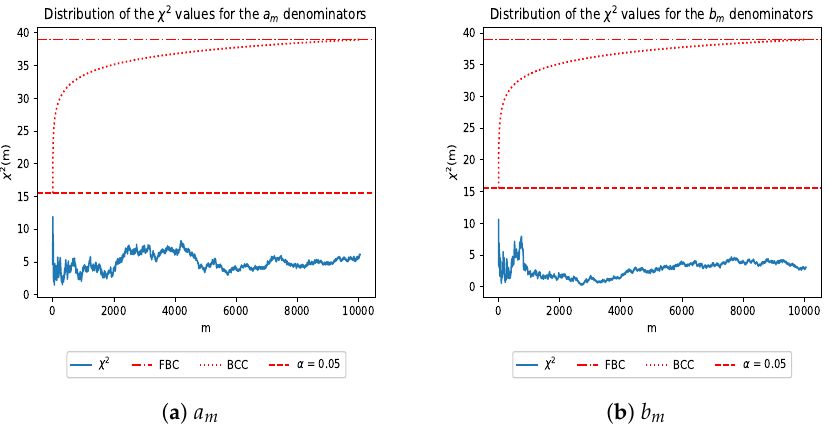
Figure 4. χ 2 distribution for the a m and b m denominators. Legend Guide: FBC-Final Bonferroni Correction, BCC-Bonferroni Correction Curve